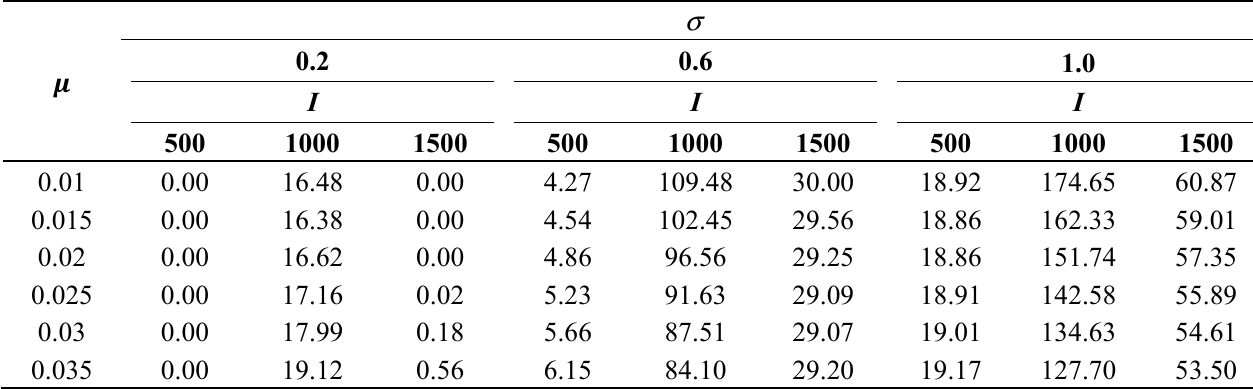
Table 5. Percentage of investment value uncaptured by